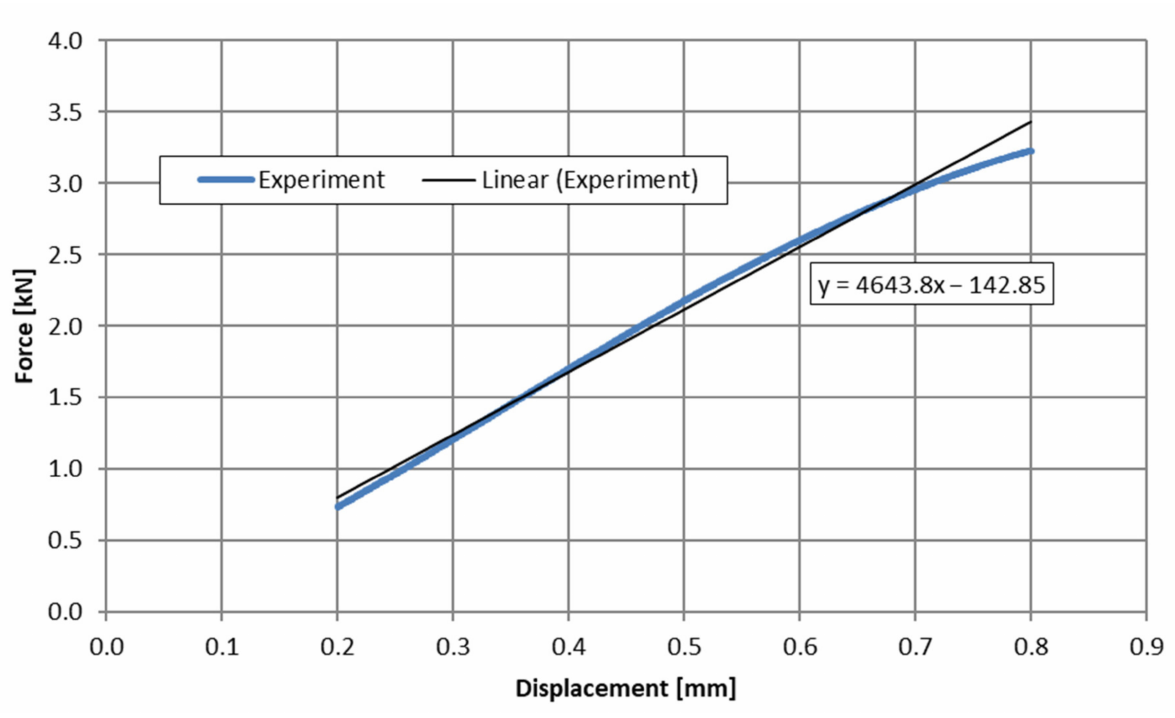
Figure 5. The principle of determining the stiffness (Young’s modulus), k exp